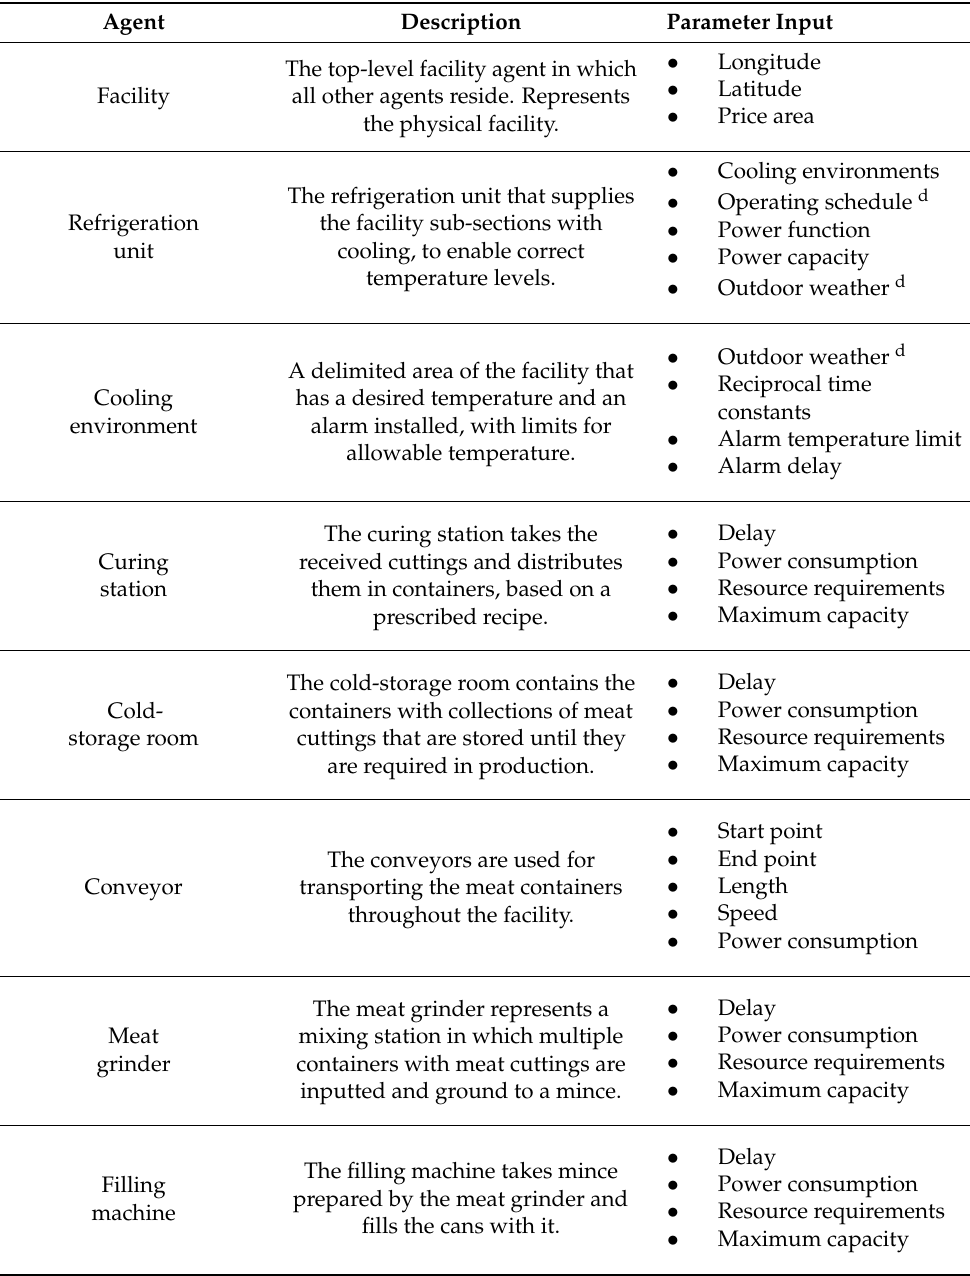
Table 1. Developed canned-meat-production facility